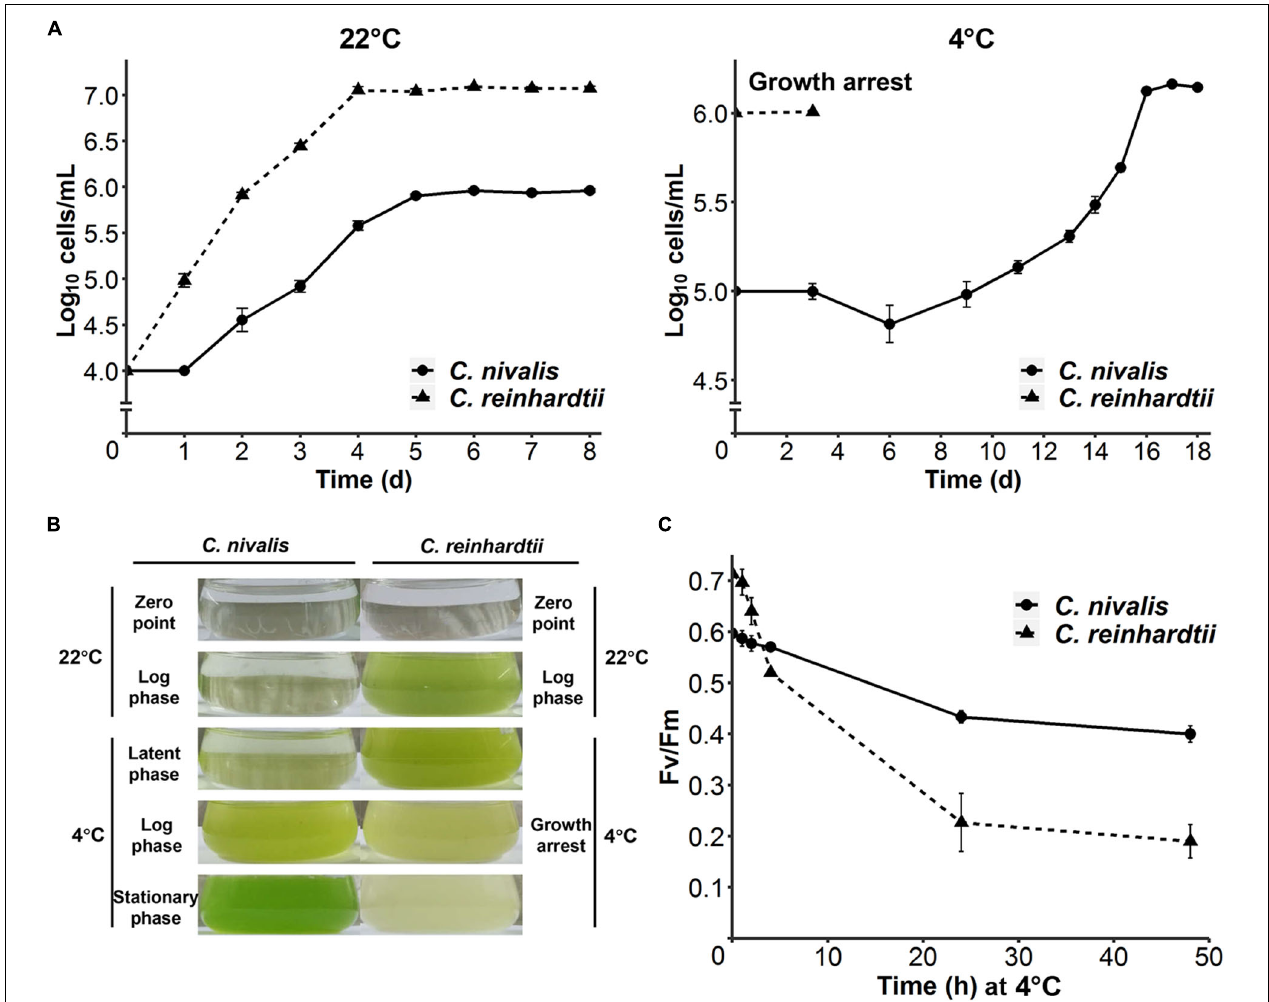
FIGURE 1 | Divergent cold acclimation capacity between C. nivalis and C. reinhardtii. (A) Growth curves of C. nivalis and C. reinhardtii at 22 ◦ C and 4 ◦ C, measured everyday (22 ◦ C) or every 2–3 days (4 ◦ C). For 4 ◦ C growth curve, algae cells at 0 h point had been cultured at 22 ◦ C until mid-log phase was reached. The error bars represent standard deviations of three biological replicates. (B) Comparison between different culture states of C. nivalis and C. reinhardtii . Photographs show culture states at five phases of growth for C. nivalis , which was grown at 22 ◦ C until mid-log phase and then transferred to 4 ◦ C. For each phase, the culture state of C. reinhardtii is shown on the right for comparison. (C) F V / F M measurement of C. nivalis and C. reinhardtii upon cold treatment. Cells at log phase were transferred to 4 ◦ C condition, and then F V /F M was measured after 1, 2, 4, 24, and 48 h. The error bars represent standard deviations of three biological